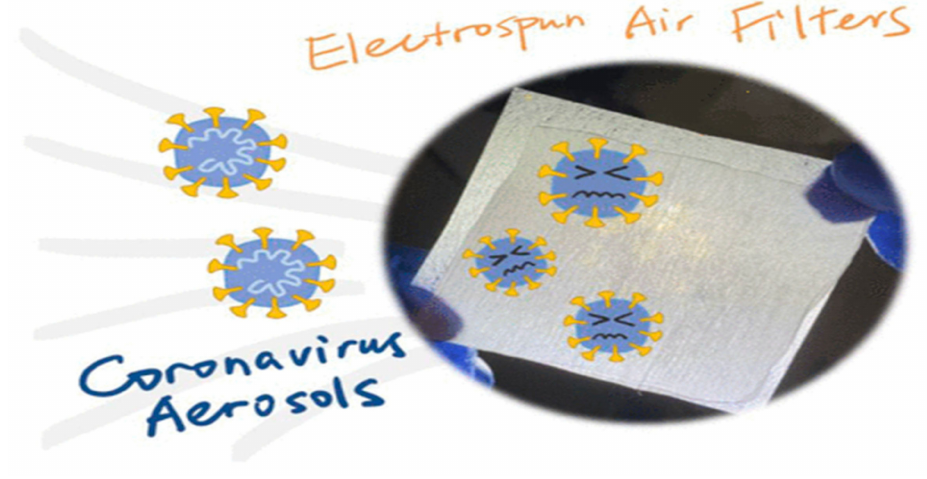
Figure 7. Coronavirus aerosols [59].